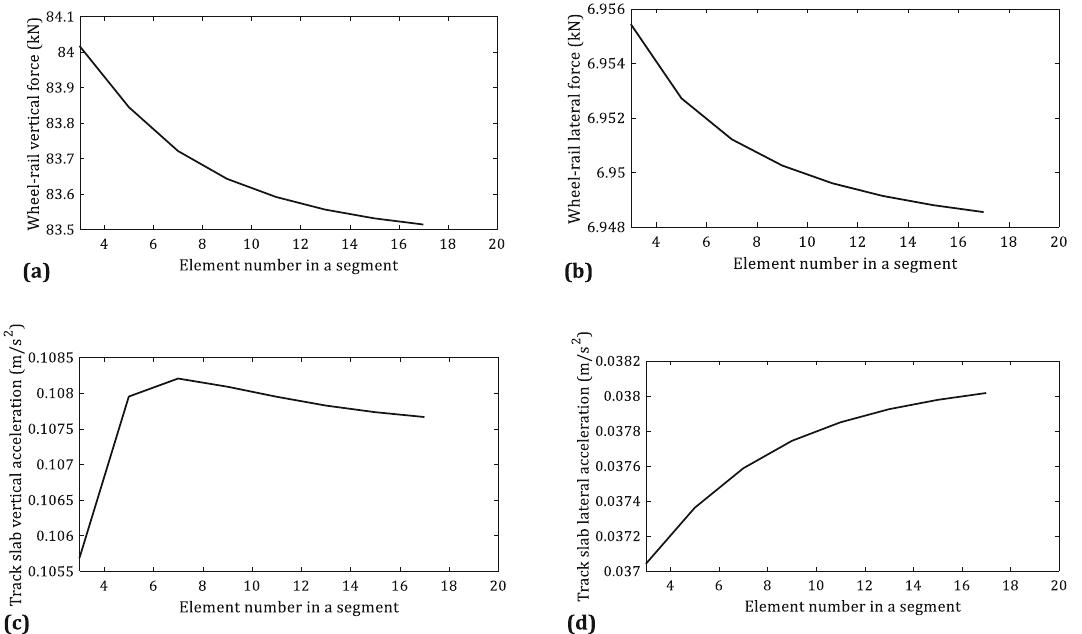
Fig. 11 Maximum responses with respect to various elemental number: a wheel-rail vertical force; b wheel-rail lateral force; c track slab vertical acceleration; d track slab lateral acceleration